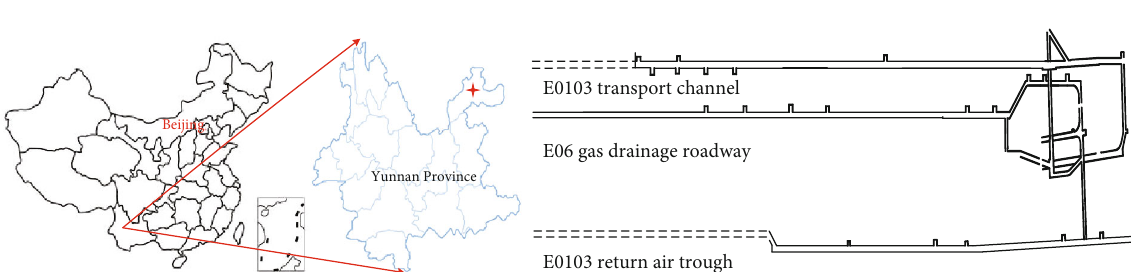
Figure 5: Schematic diagram of the test site location.